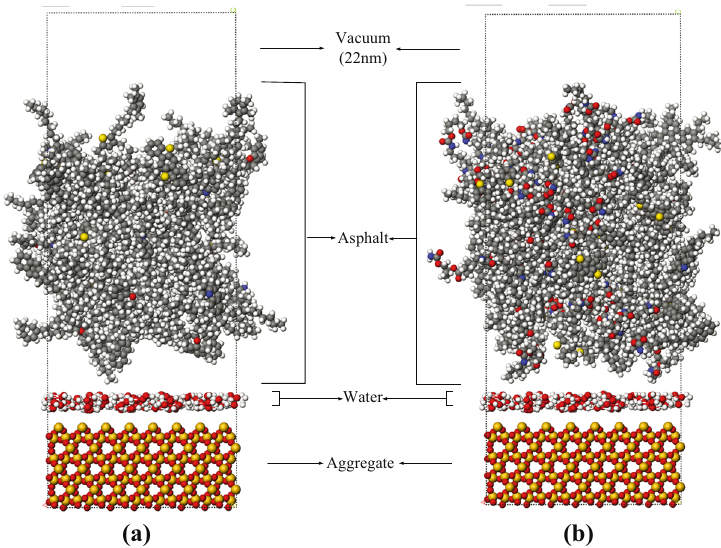
Figure 8: Interface model of asphalt and aggregate: ( a ) original asphalt – water – aggregate and ( b ) PU - modi fi ed asphalt – water – aggregate.